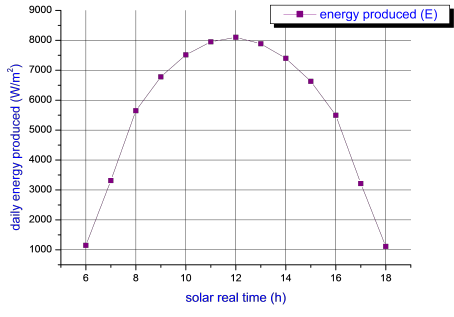
Fig. 7: Temporal evolution of the energy produced by the generator for n = 228 under a pure